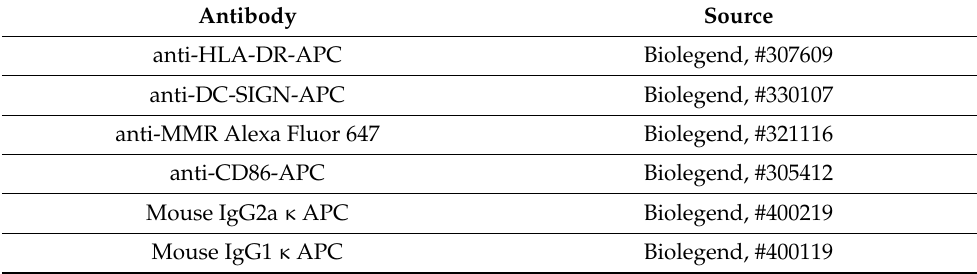
Table 3. Flow cytometry